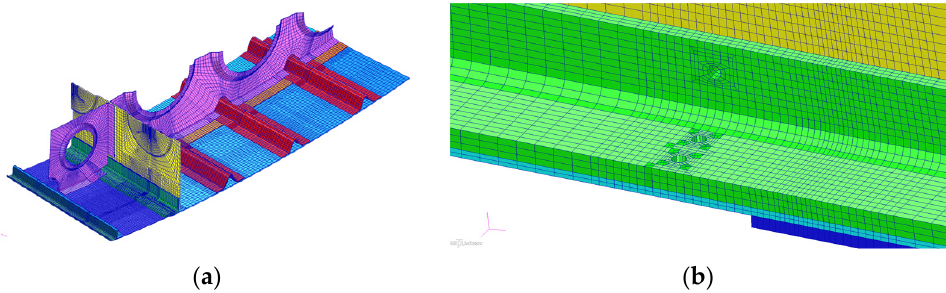
Figure 5. Finite element models of the damaged lower flange structure. ( a ) Rib No. 2 area; ( b ) rib No. 5 area.